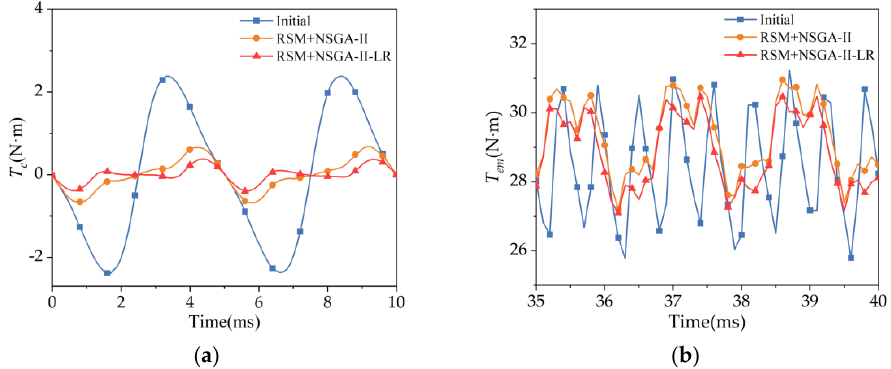
Figure 6. Results of numerical analysis before and after optimization: ( a ) curve diagram of cogging torque; ( b ) curve diagram of electromagnetic torque. Table 5. Torque performance of the motor before and after optimization.